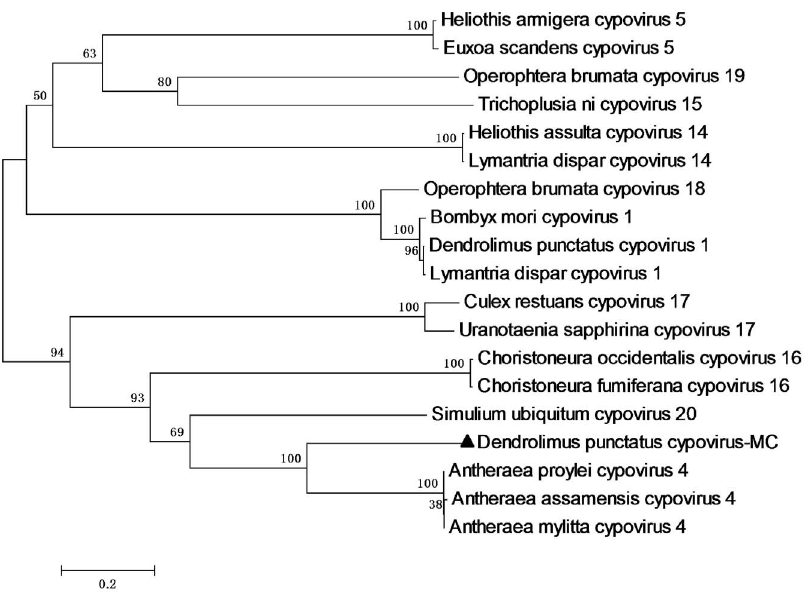
Figure 4. Neighbor-joining tree constructed from polyhedrin amino acid sequences of representative CPVs. Sequences were aligned with the multiple sequence alignment program ClustalX2. The neighbor- joining method was used to construct the phylogenetic tree of the derived polyhedrin protein sequences with the MEGA software version 5.2. The black triangle shows the position of DpCPV-MC. Bootstrap percentage values are indicated on the left. All reference sequences used for the construction of this tree were retrieved from GenBank with their corresponding accession numbers: Antheraea assamensis cypovirus 4 , AY212275; Antheraea mylitta cypovirus 4 , AY212273; Antheraea proylei cypovirus 4 , AY212276; Dendrolimus punctatus cypovirus 1 , AY204879; Bombyx mori cypovirus 1 , D37770; Culex restuans cypovirus 17 , DQ212785; Choristoneura occidentalis cypovirus 16 , EU201043; Euxoa scandens cypovirus 5 , J04338; Heliothis assulta cypovirus 14 , DQ077914; Heliothis armigera cypovirus 5 , DQ077912; Lymantria dispar cypovirus 1 , AF389471; Operophtera brumata cypovirus 18 , DQ192250; Operophtera brumata cypovirus 19 , DQ192254; Simulium ubiquitum cypovirus 20 , DQ834386; Trichoplusia ni cypovirus 15 , NC_002565; Uranotaenia sapphirina cypovirus 17 , AY876384; Lymantria dispar cypovirus 14 , AF389461; Choristoneura fumiferana cypovirus 16 ,